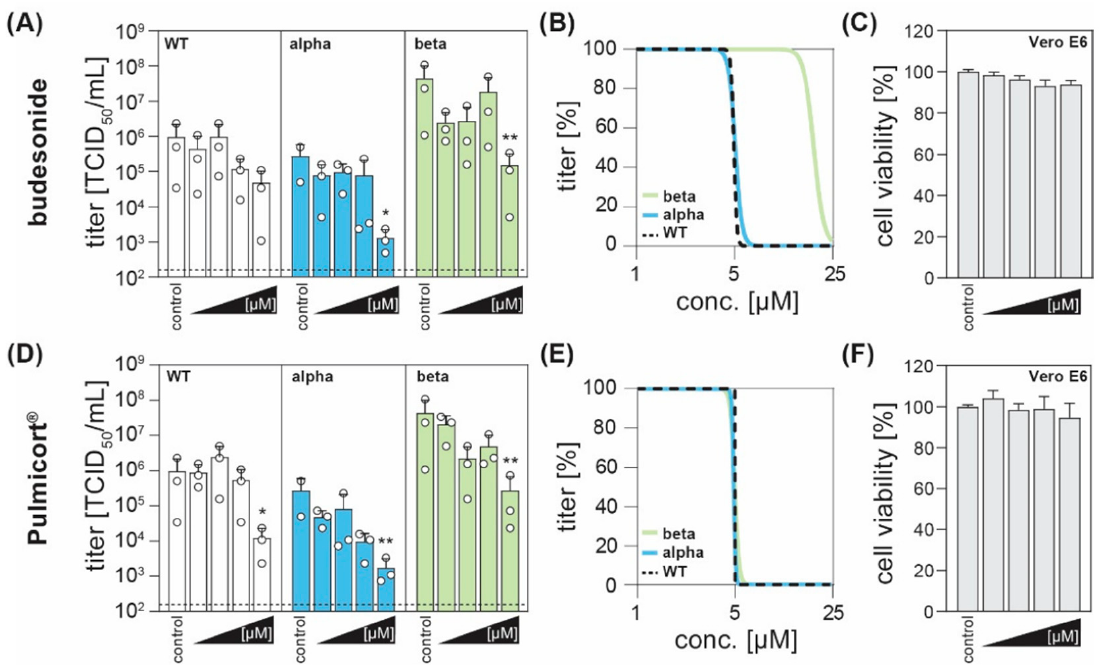
Figure 1. The corticosteroid budesonide acts antiviral against SARS-CoV-2 in vitro. ( A , D ) Vero E6 cells were infected with the SARS-CoV-2 variants B1.1.70 (WT, white), B.1.1.7 (alpha, blue), or B1.351 (beta, green) at a MOI of 0.1 and simultaneously treated with increasing concentrations of budesonide (Selleck Chemicals; dissolved in DMSO) or Pulmicort ® (AstraZeneca; suspension containing 0.5 mg budesonide per 2 mL), in concentrations of 0.1, 1, 5 and 25 µ M. 24 h post infection, viral titers were determined by limited dilution assay and are depicted as TCID 50 /mL (three independent experiments indicated by open circle with bars depicting mean +SD; * p < 0.05, ** p < 0.01, ANOVA followed by Dunnett’s corrected t-test versus respective controls). ( B , E ) Four parameter log-logistic regression analyses were performed using the least squares fitting method implemented in GraphPad Prism v9.1. ( C , F ) Cytotoxicity was measured with the CytoTox 96 ® non-radioactive cytotoxicity assay (Promega). Depicted are the normalized mean +SD of three independent experiments.